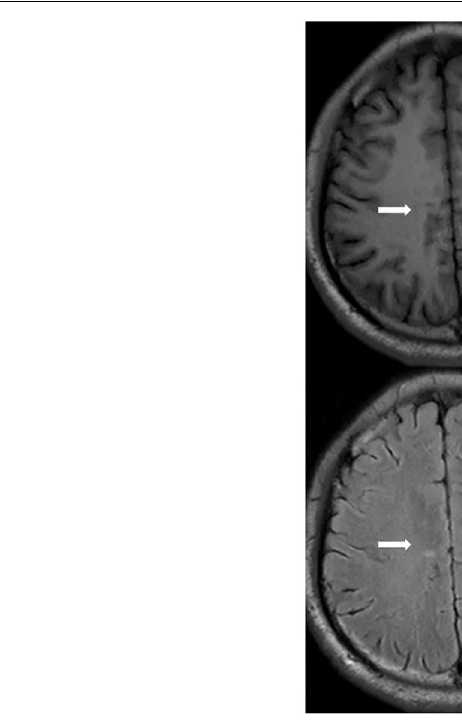
FIGURE 1 | A patient presented MOG-Ab positive followed aseptic meningitis. Axial T1 (upper left), T2 (upper right), T2-Flair images (bottom left) showed long signal lesions on bilateral cingulate gyrus, right corpus callosum and frontal lobe, left semi-oval center (white arrowhead). T1-contrast weight images (bottom right) showed nodular enhancement (yellow